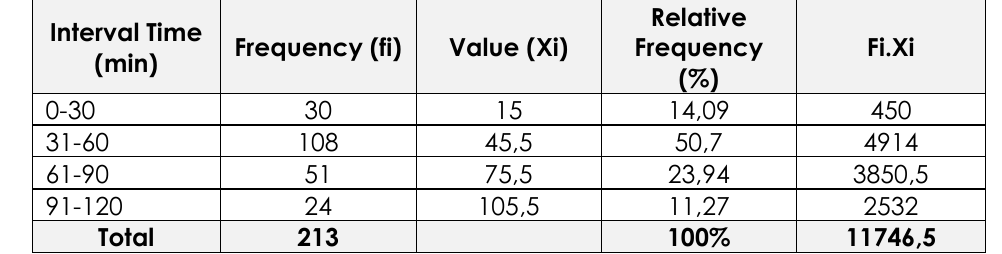
Table 3. Average Number of Services Per Hour Mechanical